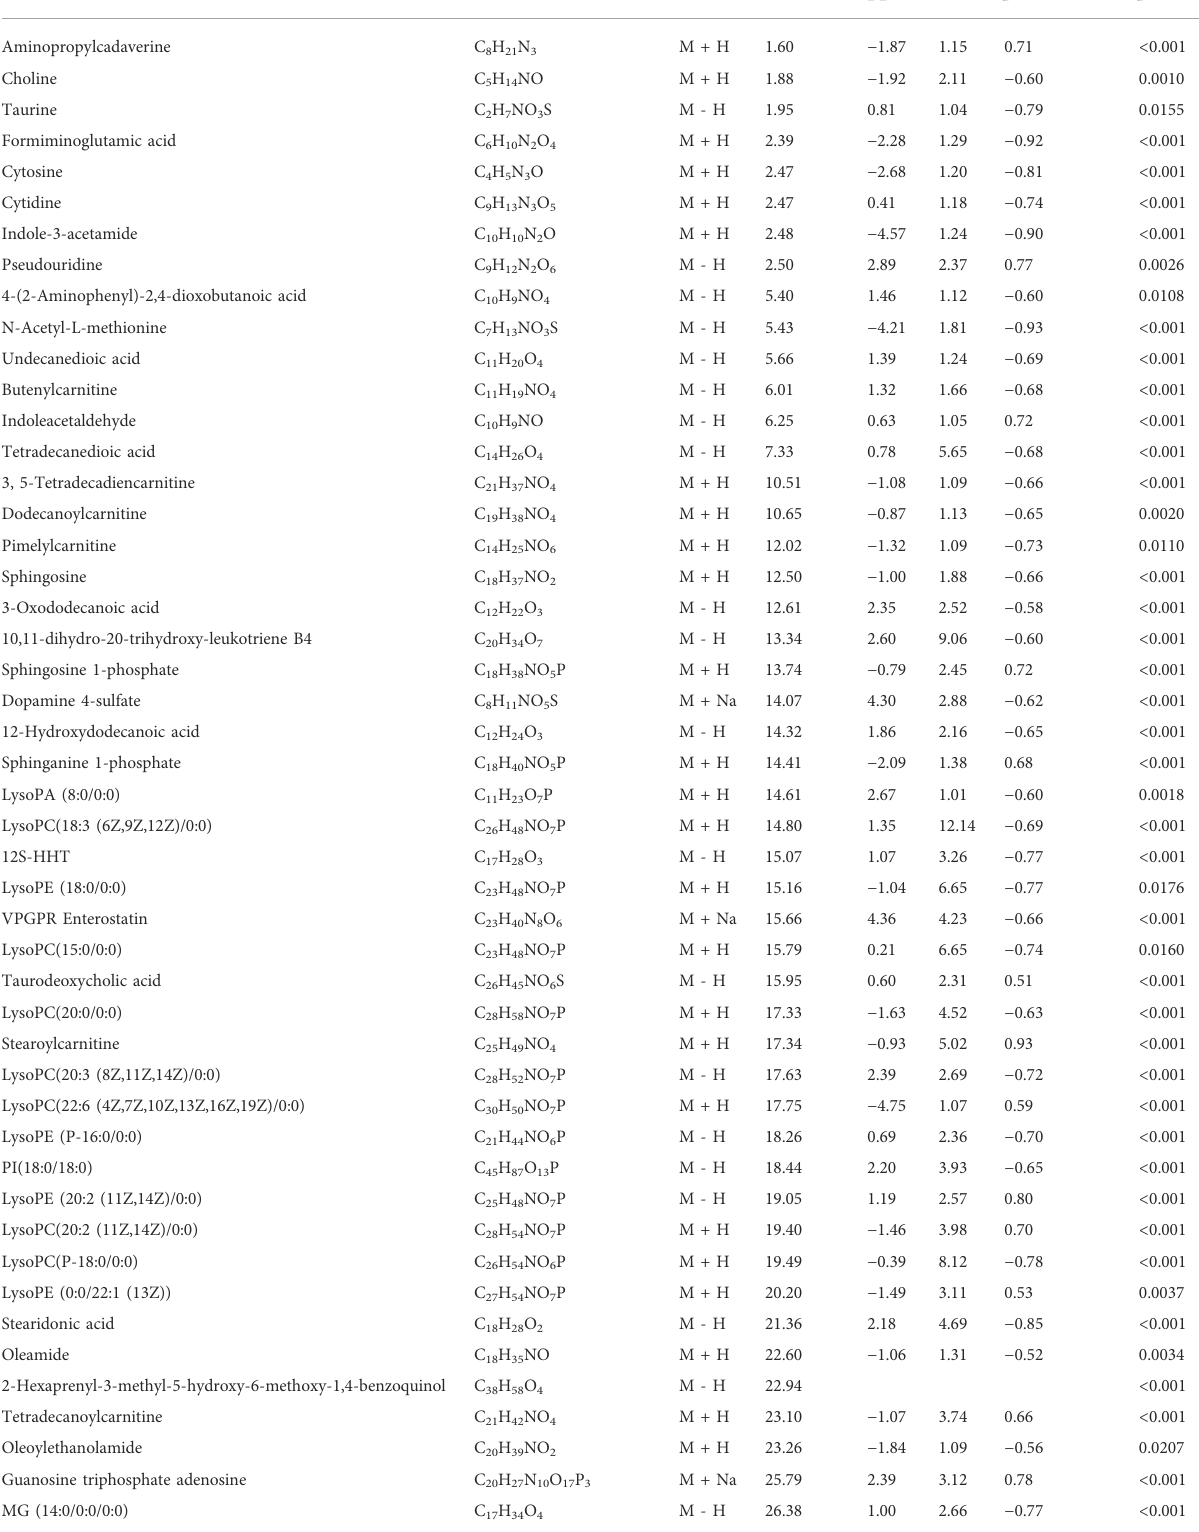
TABLE 1 Identi fi ed differential metabolites in serum between control group [C] and model group [M] in positive ion model and negative ion